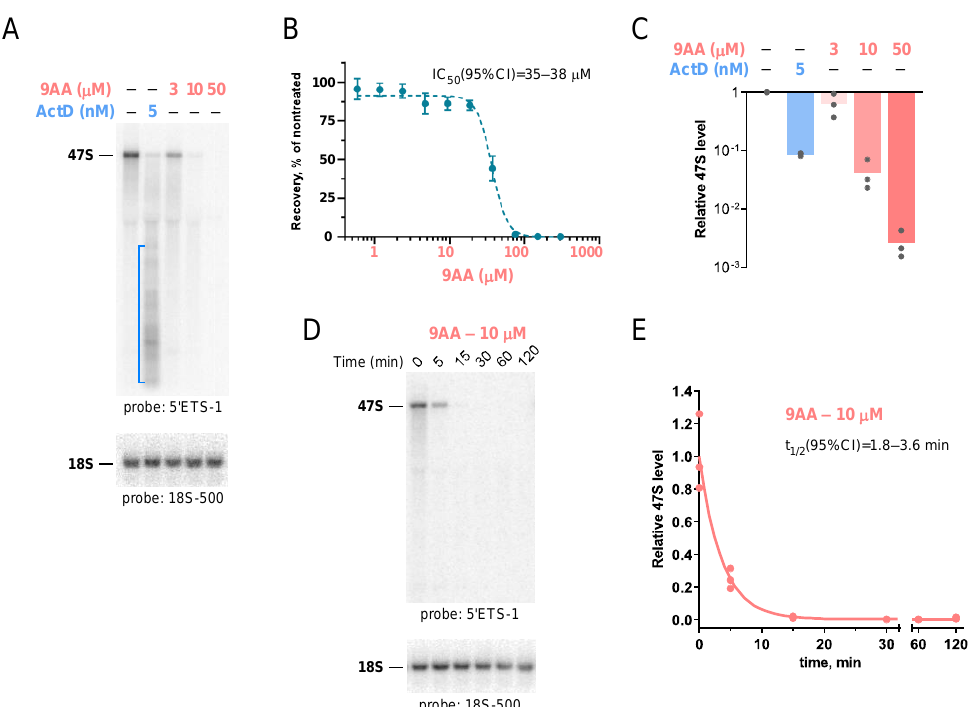
Figure 1. 9AA reduces 47S pre-rRNA levels in NIH 3T3 cells. ( A ) Northern hybridization of RNA from cells treated with different concentrations of 9AA or ActD for 2 h. Products of Pol I transcription were visualized with probe 5 ’ ETS-1 (top panel); the same blot was then rehybridized with probe 18S-500 (bottom panel) to control loading. The bracket marks the smear of incomplete Pol I transcripts accumulating after ActD treatment. ( B ) The number of viable, metabolically active cells determined using an Alamar blue assay at 72 h after a 2 h 9AA treatment, relative to untreated cells. n = 5; error bars indicate s.d. IC 50 was estimated using a variable-slope dose-response model. ( C ) Relative abundance of the primary 47S pre-rRNA transcript. Hybridization signal of full-length 47S was normalized by 18S in the same lane to correct for loading variation; bars show mean values obtained from 3 replicate cell cultures. ( D ) Representative time course of a 10 μ M 9AA treatment. Northern hybridizations were performed as in ( A ). ( E ) Change in the primary 47S transcript levels over time after cell exposure to 9AA. Data from 3 replicate cell cultures were fit to a one-phase exponential decay equation.